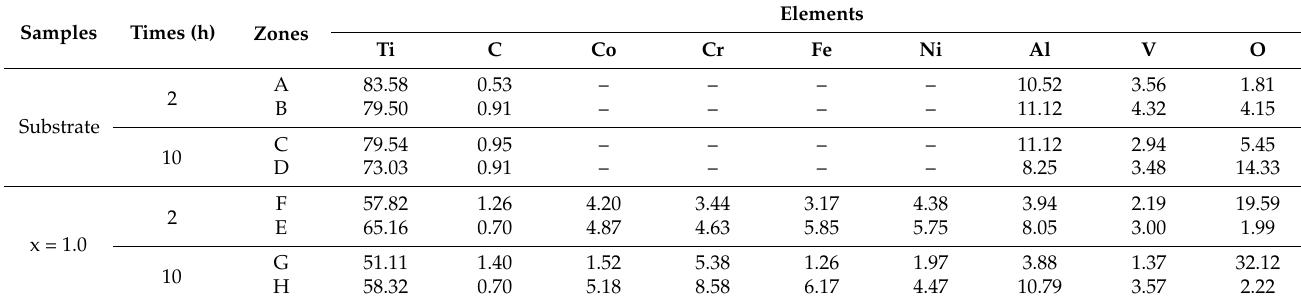
Table 5. Chemical compositions (at.%) marked in Figure